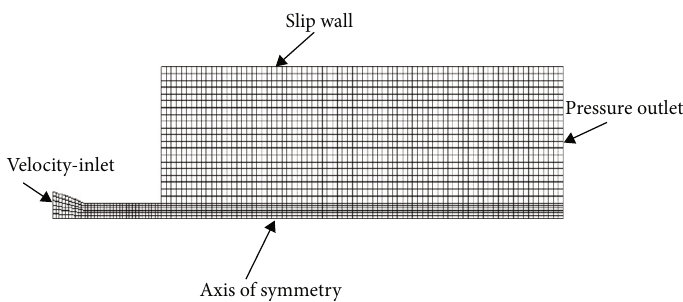
Figure 1: Modeling notation.